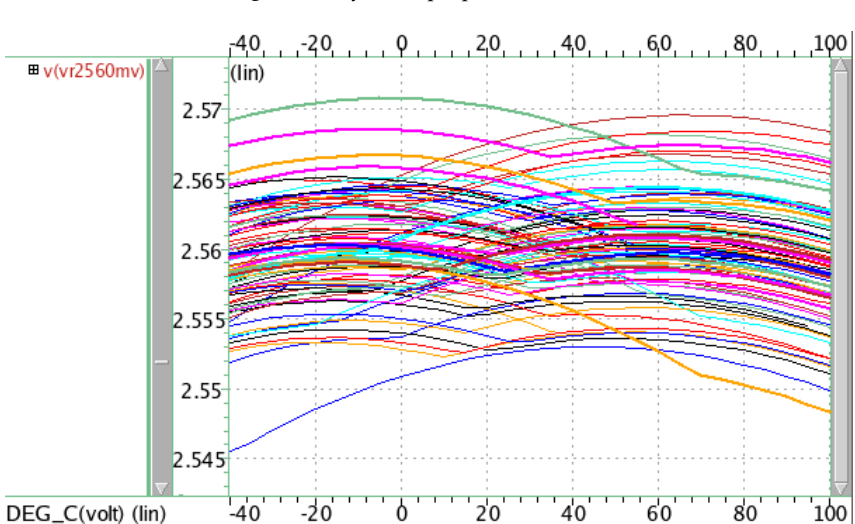
Figure 10. Monte Carlo simulation results of proposed SPWBGR.